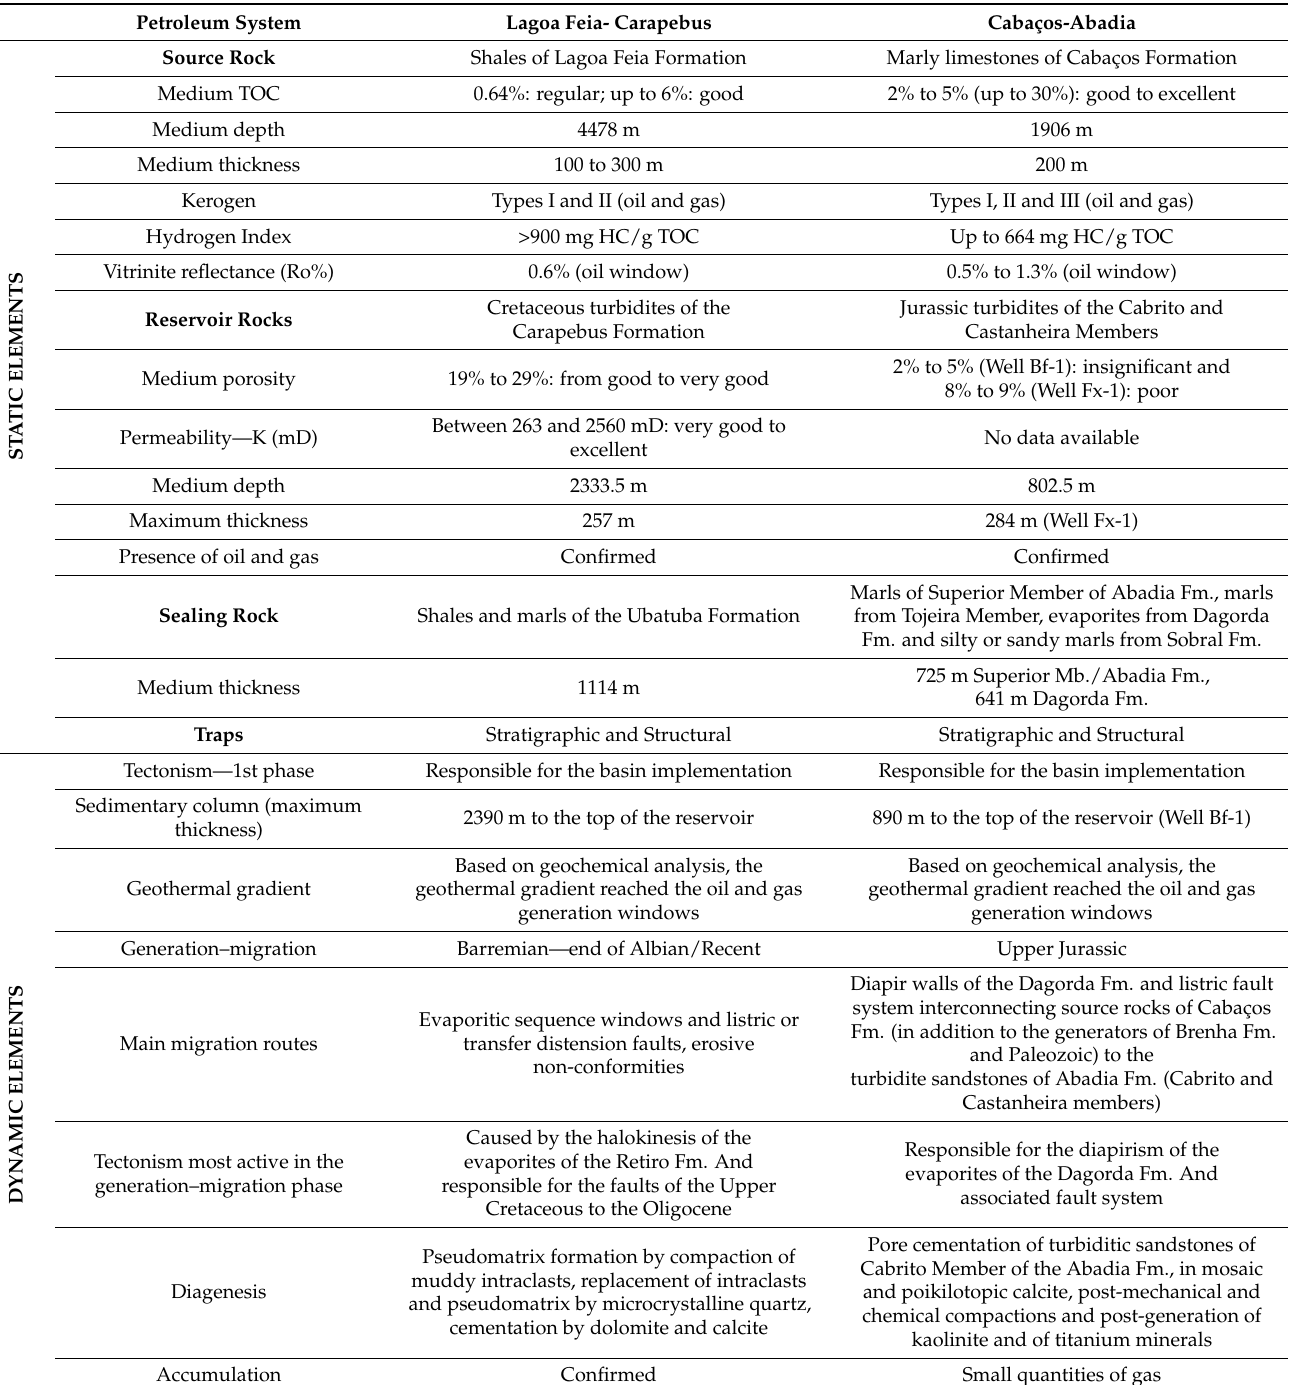
Table 1. Analysis of the efficiency of the static and dynamic elements, timing and economic aspects of the proven petroleum